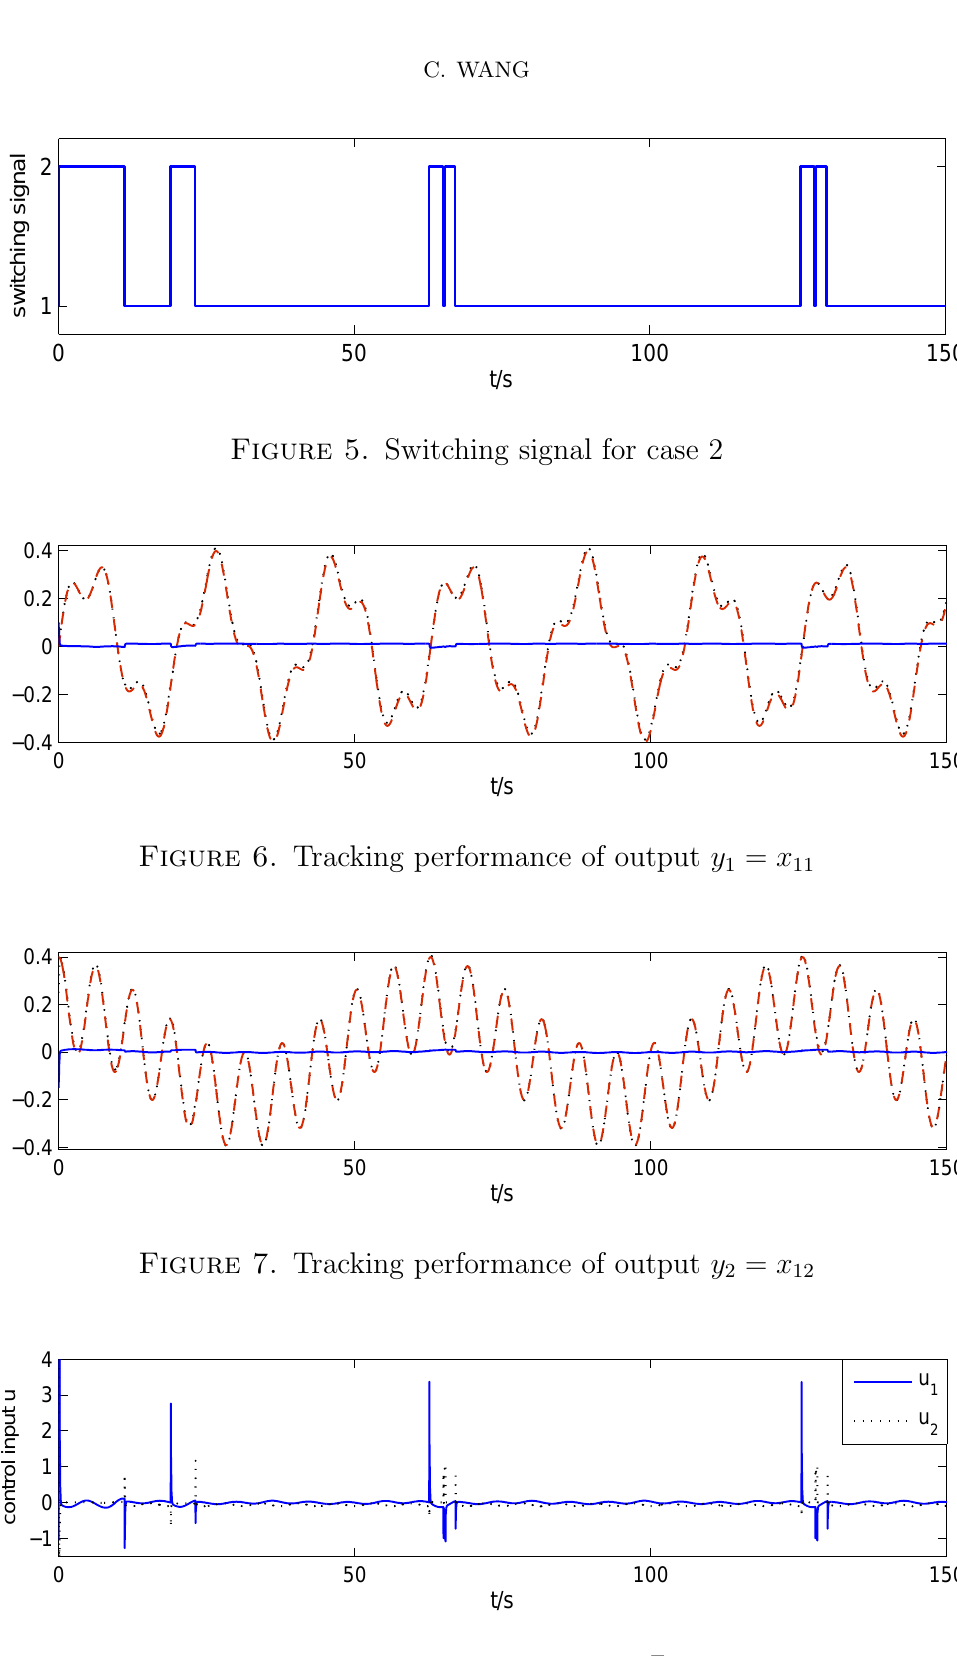
Figure 8. Control signal u = ( u